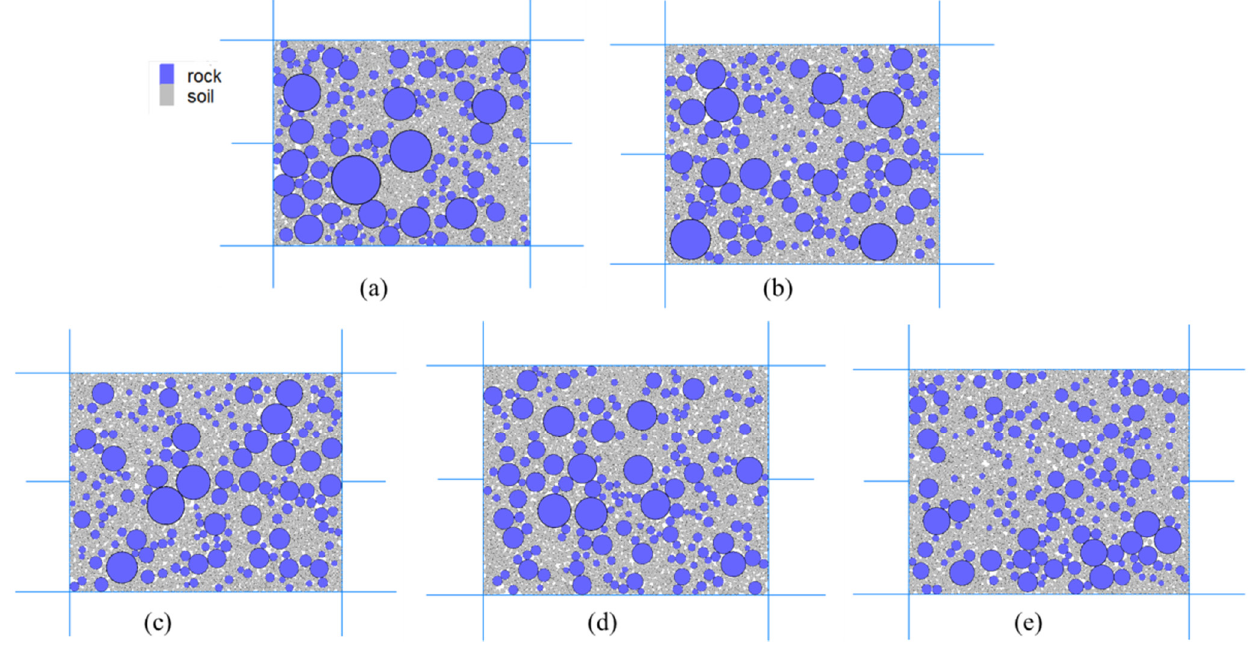
Figure 8. Particle models of SRM samples with different maximum particle diameters. ( a ) S1, ( b ) S2, ( c ) S3, ( d ) S4, and ( e ) S5. Table 1. Numerical test